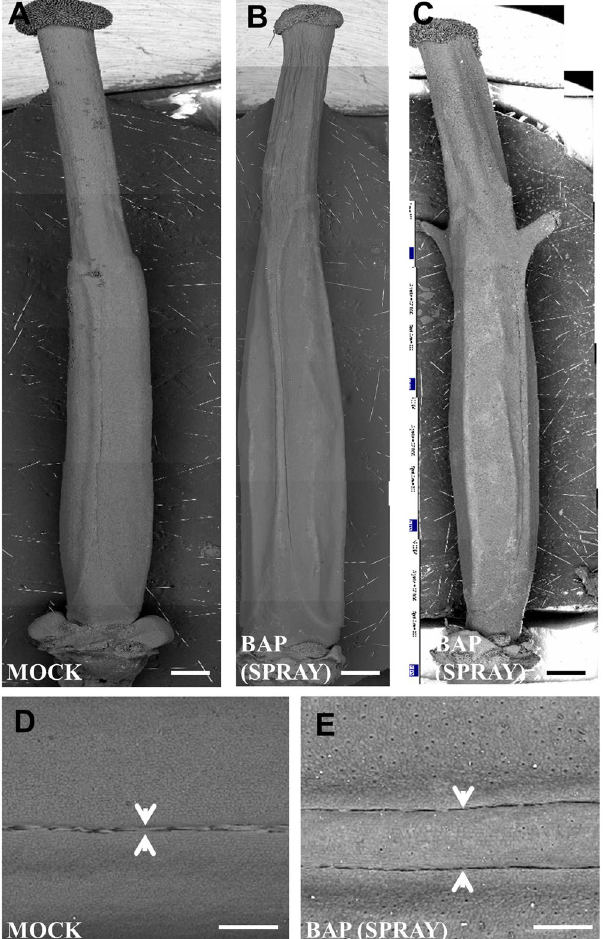
Figure 5. Exogenous BAP application affects replum development in gynoecium of Brassica napus . ( A ) Mock- treated gynoecium. ( B , C ) BAP-treated gynoecium that developed a wider replum. ( C ) BAP-treated gynoecium that developed extra tissues from the replum. ( D ) A zoom of a Mock-treated gynoecium where the replum is shown. ( E ) A zoom of a BAP-treated gynoecium where the replum is shown. Arrowheads indicate replum width. Scale bars: ( A – C ) 5 mm; ( D , E ) 200 µ